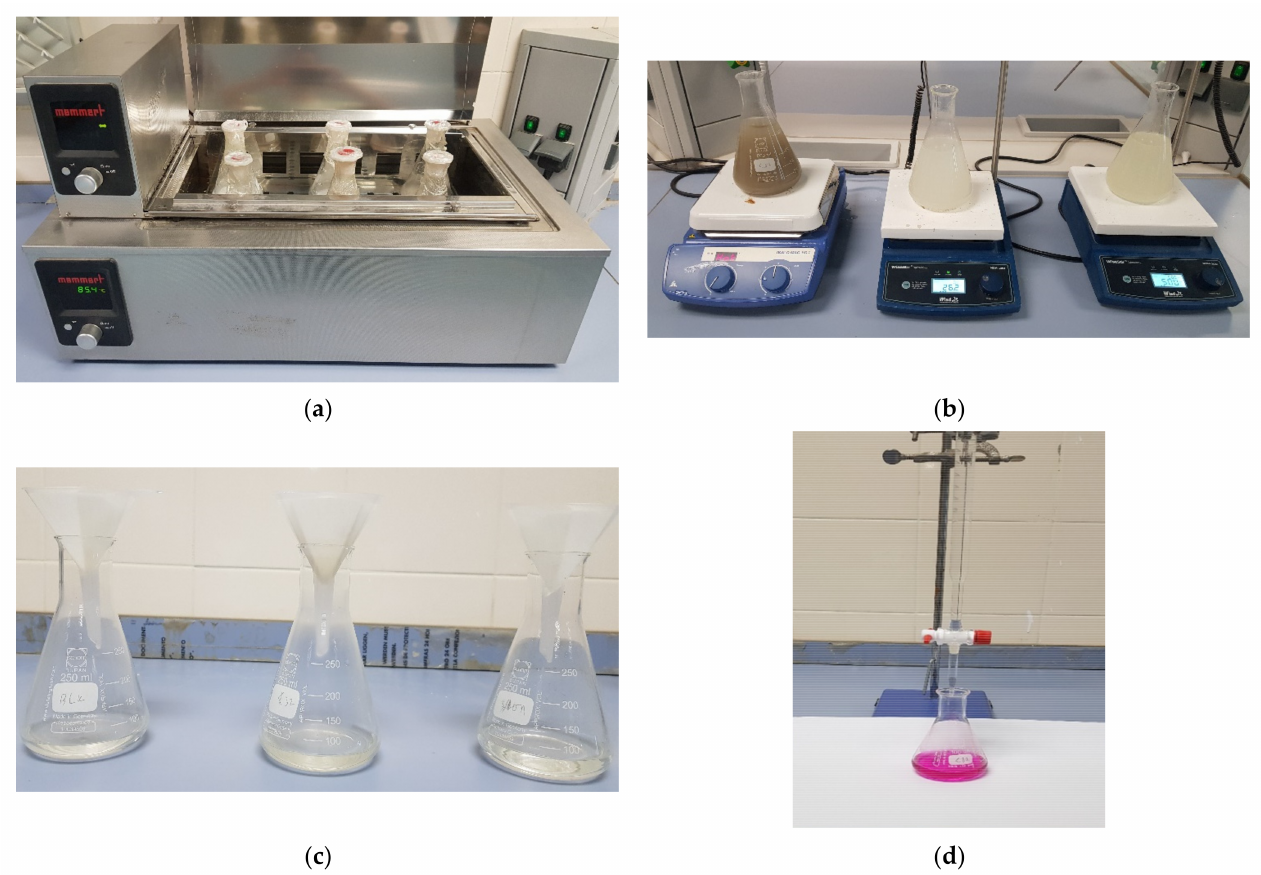
Figure 5. Illustration of the several steps performed to determine Chappelle activity. ( a ) Samples and blank placed in the water bath; ( b ) mixing after adding sucrose solution; ( c ) filtration of the samples; and ( d ) The filtrated